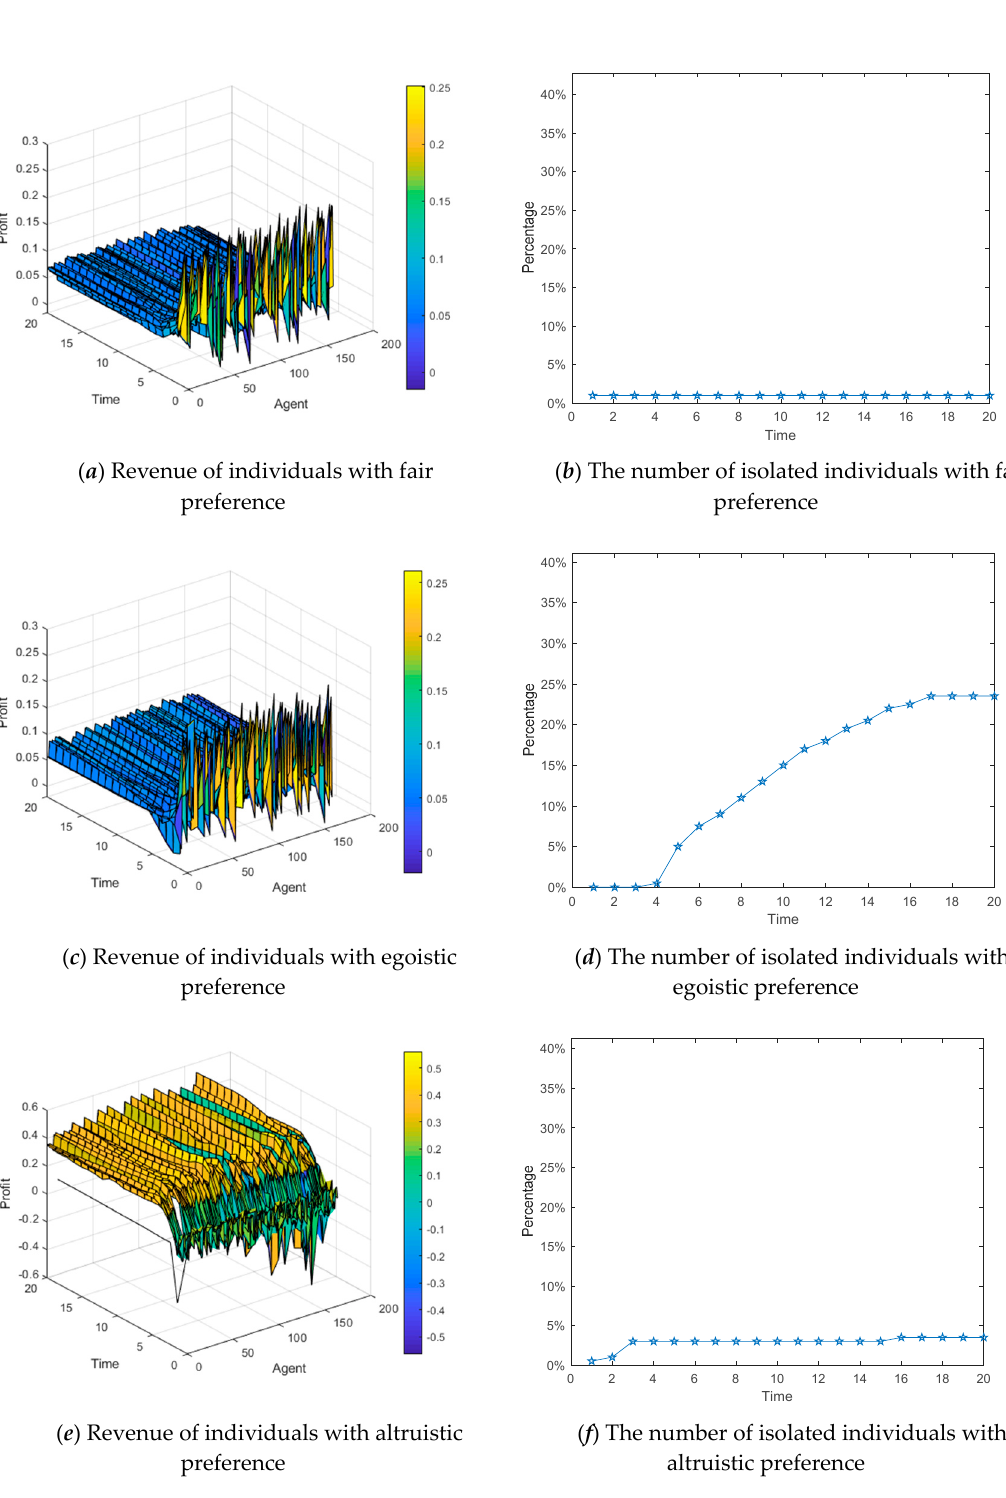
Figure 20. The influences of different preferences on individual revenue.